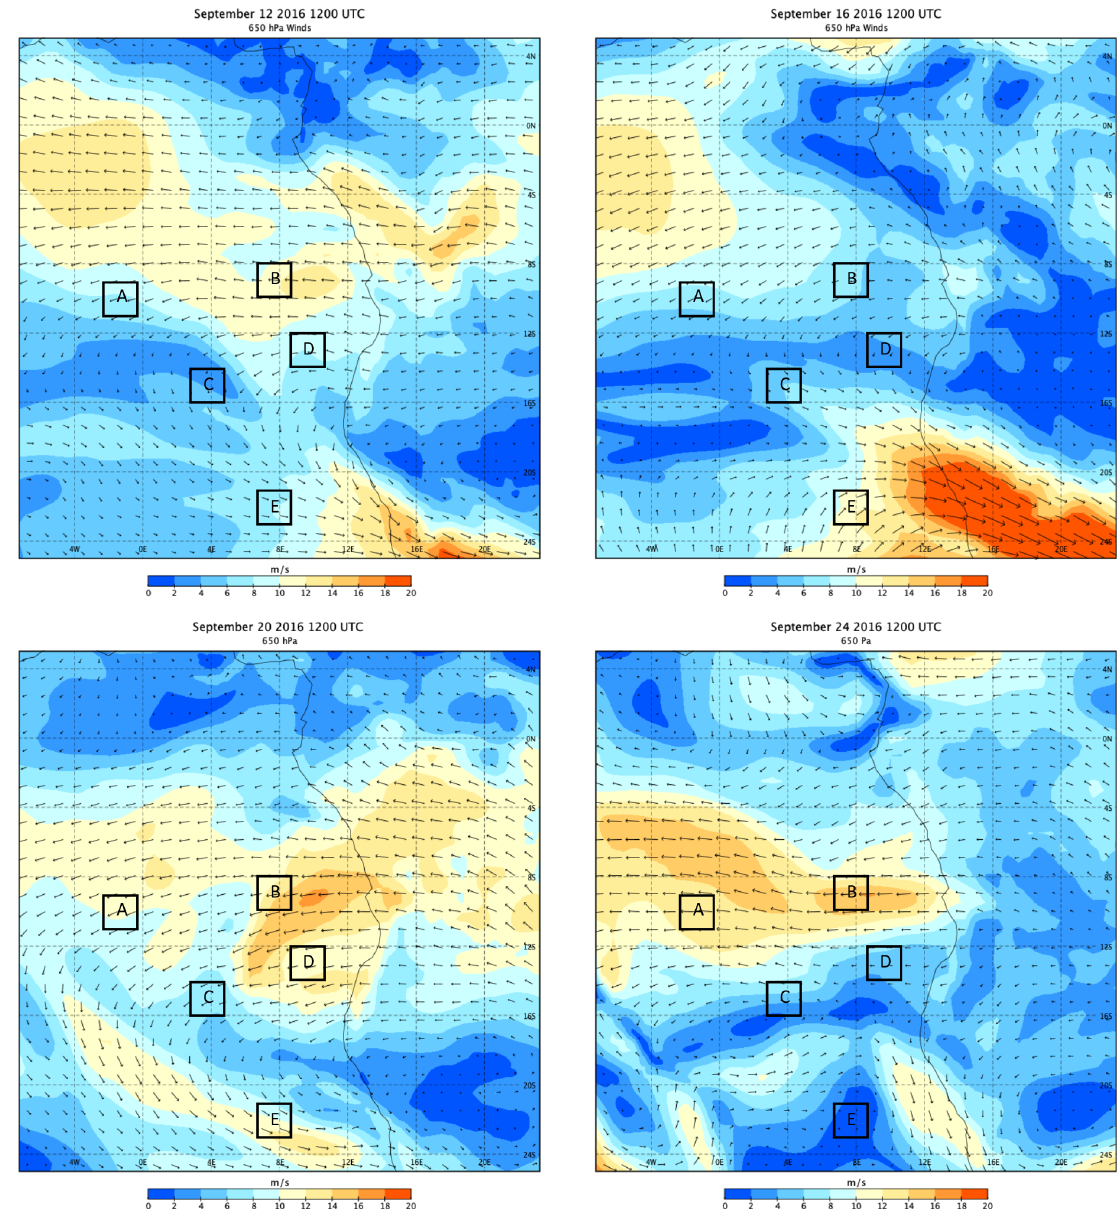
Figure 2. MERRA2 reanalysis of 650hPa winds at 12:00UTC on 12, 16, 20, and 24 September 2016. Grid boxes in the study are marked with